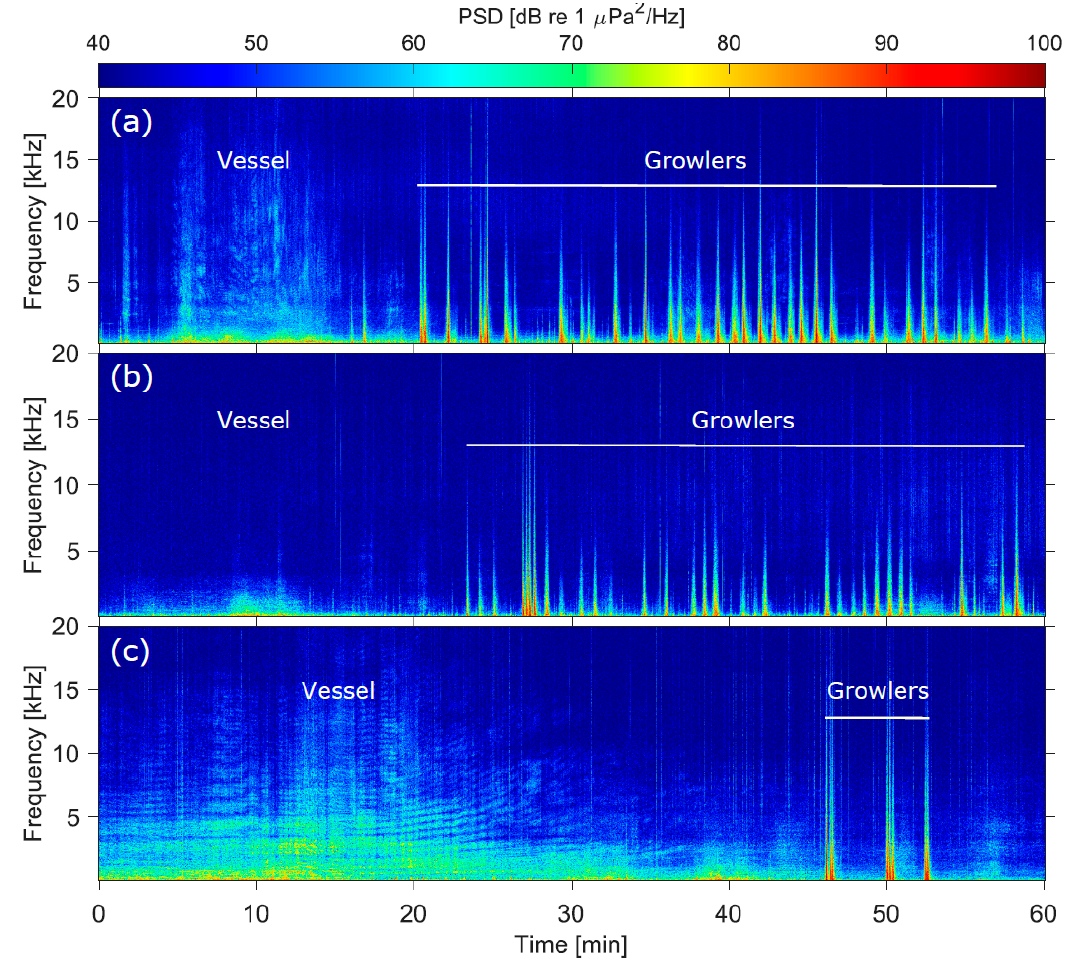
Figure 6. One-hour spectrograms (fs = 96 kHz, NFFT = 96,000, 0% overlap) contrasting underwater sound from Growlers juxtaposed with examples of vessel noise: ( a ) FCLP sessions on August 20